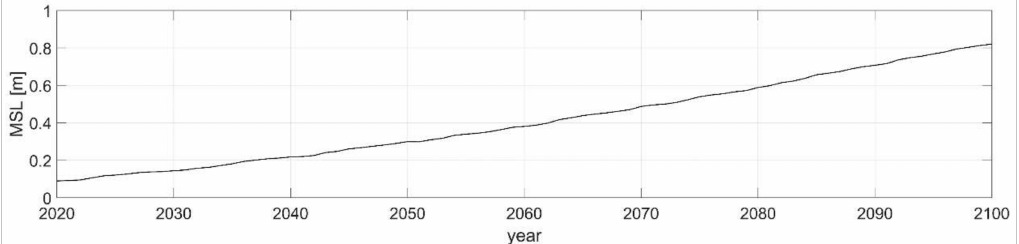
Figure 6. Future mean sea level time series estimated at Truc Vert using median SROCC sea-level rise projections in the RCP8.5